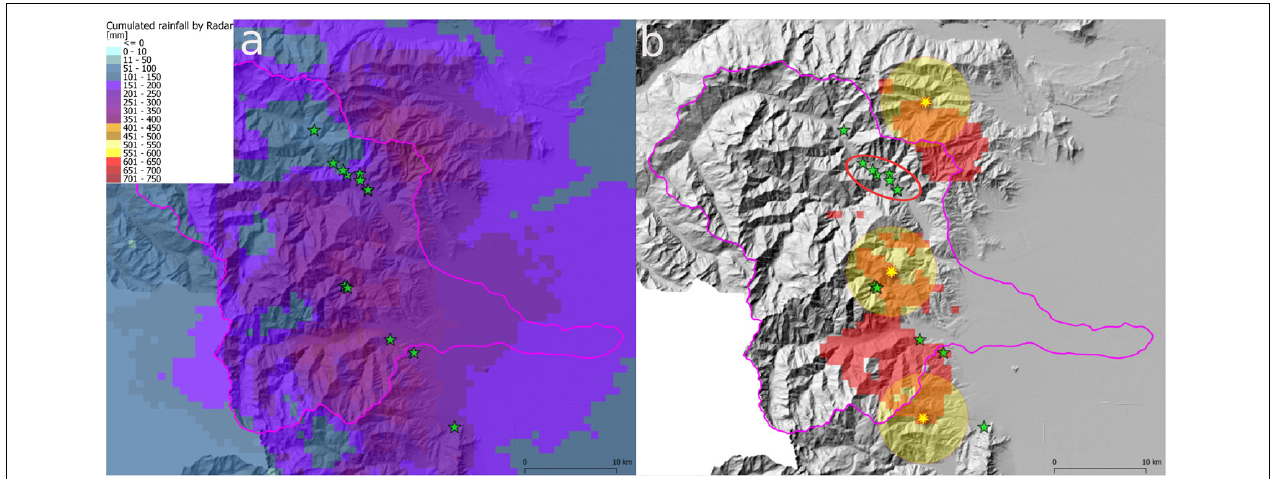
FIGURE 9 | (a) Accumulated rainfall from 24th November at 15:00 UTC in Pellice-Chisone. (b) In red, areas interested by precipitations that overpassed thresholds of Equation 3 (critical rainfall accumulations) and rain gages overpassing threshold (yellow asterisks) and related buffers (yellow circles); green star labels indicate occurred landslides; red circle include reported debris flows that reached the alluvial fans’ areas generated from shallow landslides triggered at the basins’ head and propagated along channel